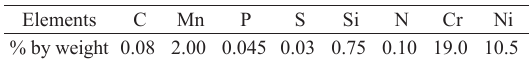
Table 1. Chemical composition (% w/w) of stainless steel 304 used as a substrate (Iron is left). Elements